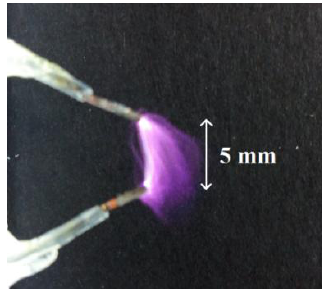
Figure 4. Neutral argon plasma arc when an electric discharge occurs between the two